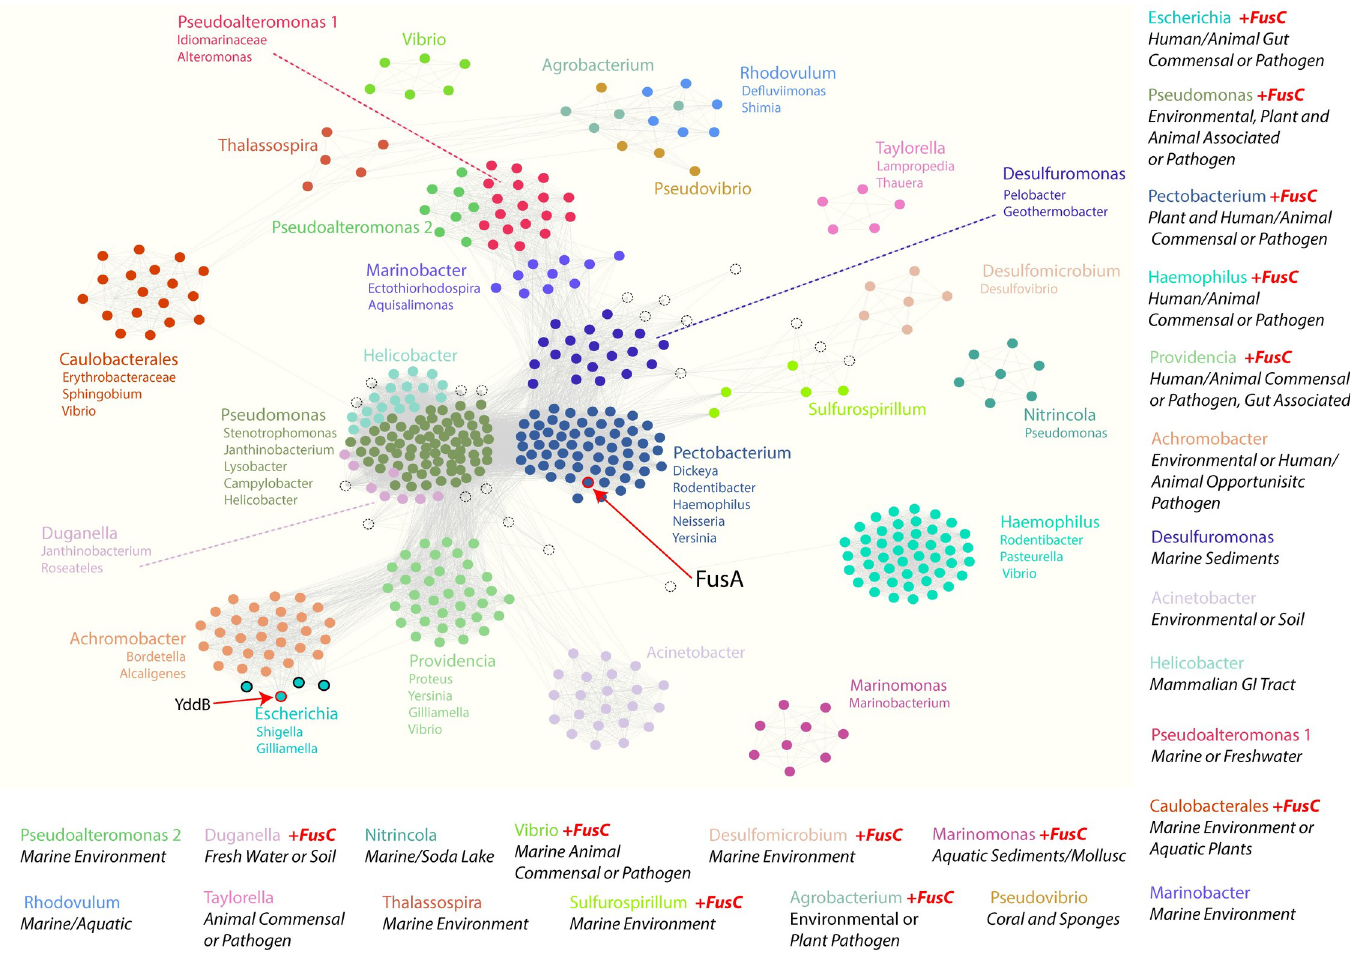
Fig 1. Clustering analysis of FusA homologues. CLANS similarity network analysis identifies clusters of sequences in the FusA homologues identified by HMMER search of the UniProt reference proteomes dataset. Clusters are named based on the genus of a major species of origin for the cluster, with members of other prevalent genera listed. The presence of FusA sequences associated with the homologues of the protease FusC inside a cluster are noted, as is the most common lifestyle for bacteria in the cluster. Dots represent individual sequences and grey lines represent pairwise similarity relationships. An E-value cut-off of 1e-110 was used for clustering. A full list of sequences and metadata where available is provided in S1